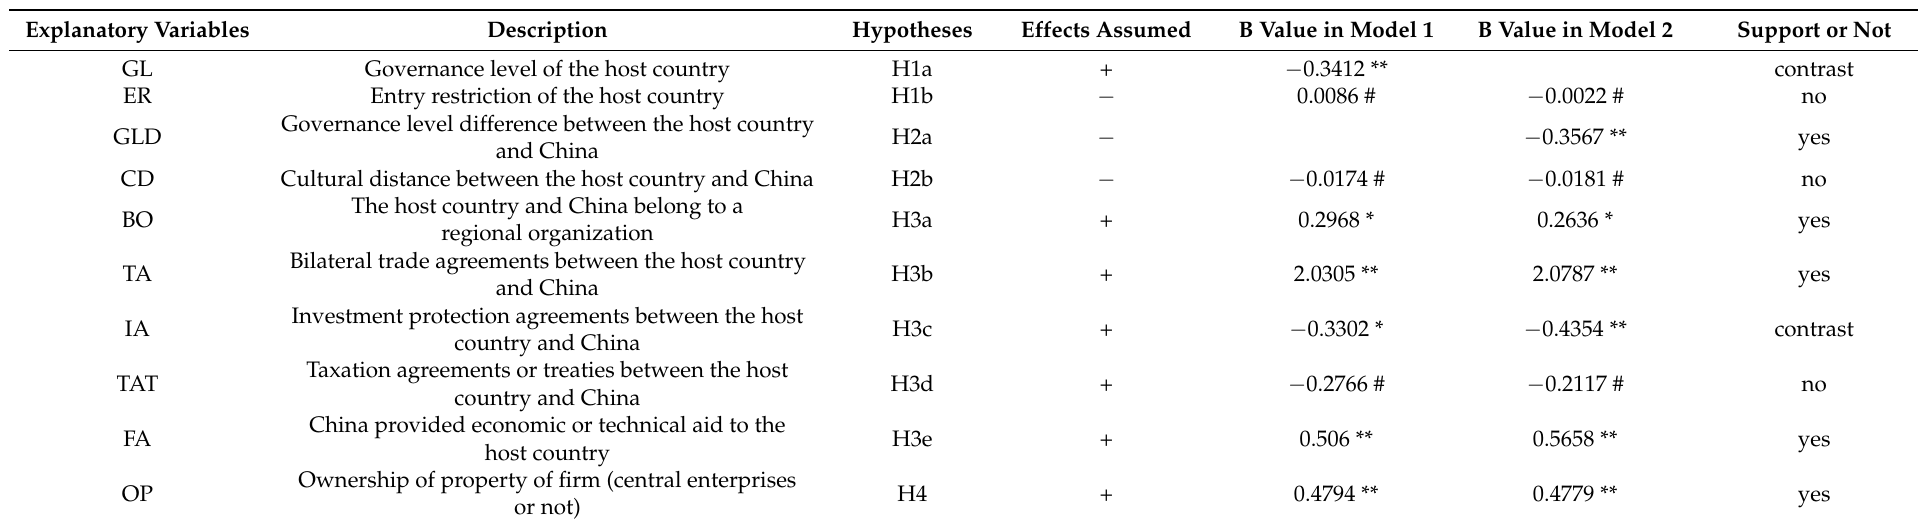
Table 5. Explanatory variable description and hypotheses test